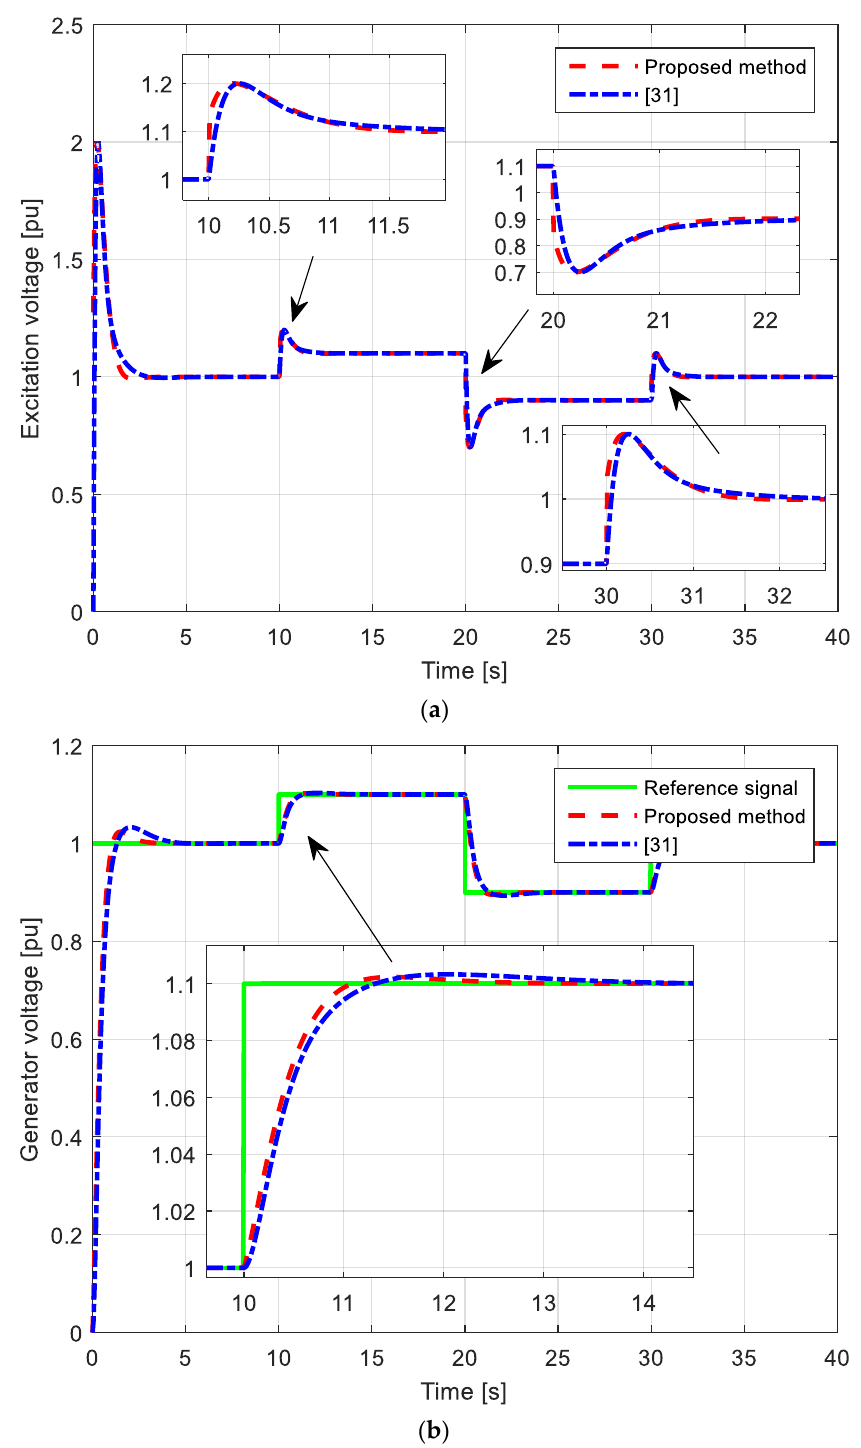
Figure 14. Set-point variation of the generator voltage. ( a ) Excitation and ( b ) generator voltage re- sponses.